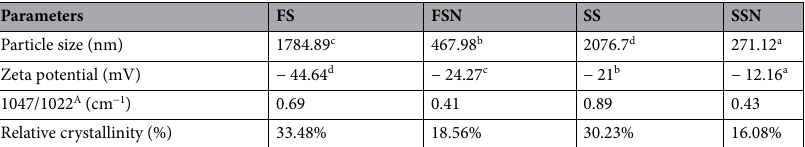
Table 1. Particle size, zeta potential, molecular order obtained by ATR-FTIR and relative crystallinity quantified by XRD of native and nano starch samples. Values expressed are mean ± standard deviation. Means in the row with different superscript (a, b, c & d) are significantly different at P ≥ 0.05. FS, FSN, SS and SSN represent native foxtail millet starch, nano foxtail millet starch, native sorghum starch and nano sorghum starch, respectively. A The ratio of absorbances at wavenumbers